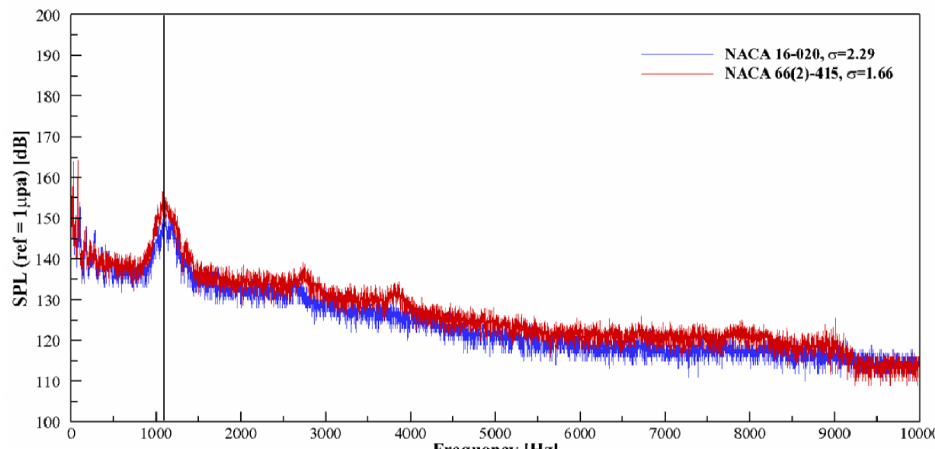
Figure 11. Comparison of noise characteristics of TVC attached to the tip of the